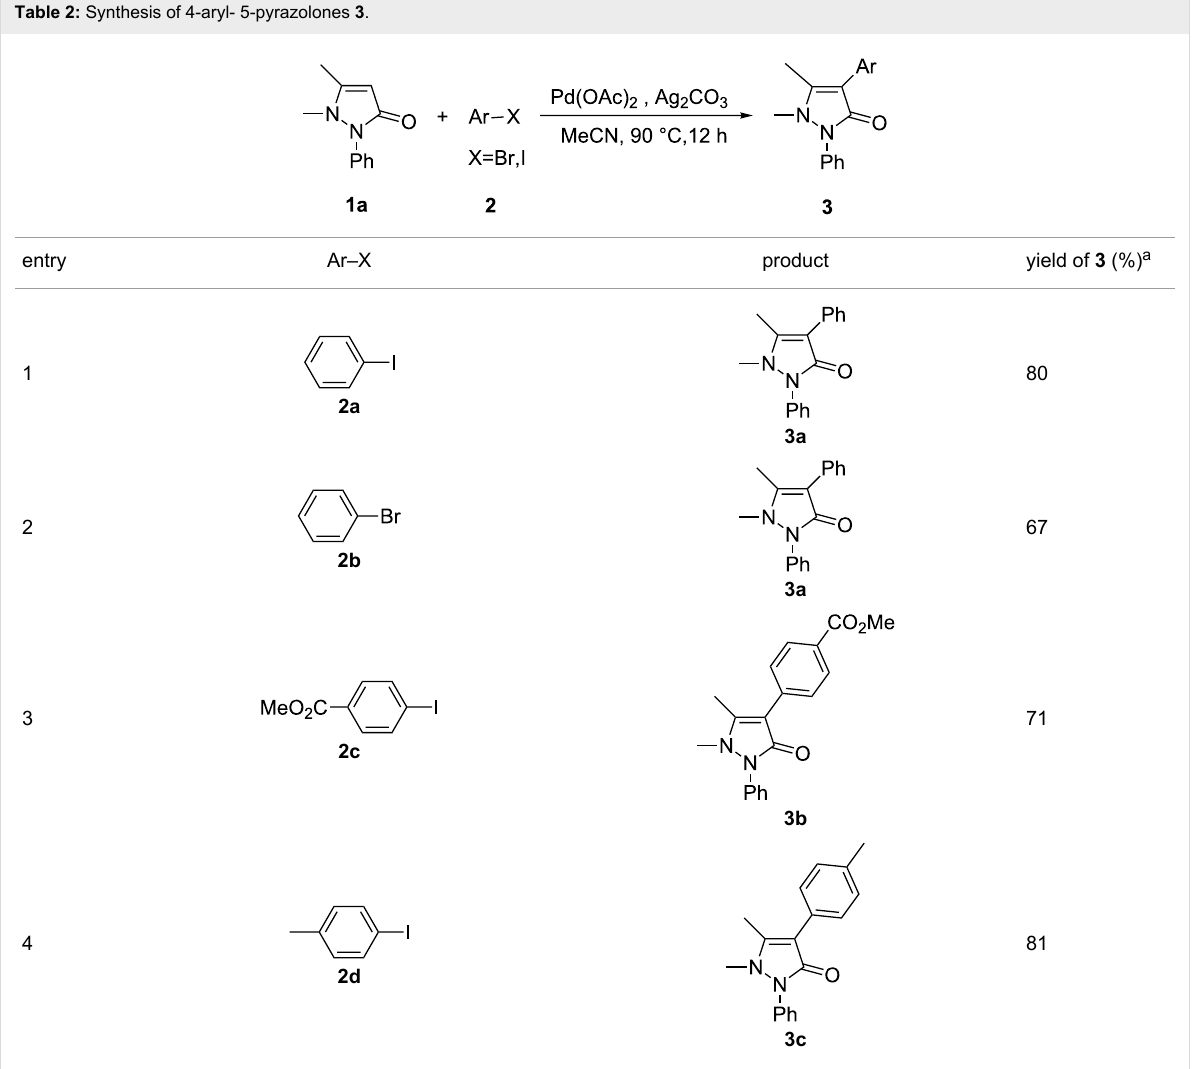
Table 2: Synthesis of 4-aryl- 5-pyrazolones 3